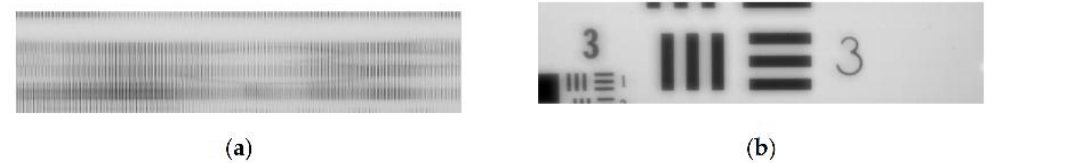
Figure 19. 256 × 2048 image using TuMag camera. ( a ) Unordered 256 × 2048 image; ( b ) Ordered 256 × 1024 image; ( c ) Ordered 256 × 256 image.